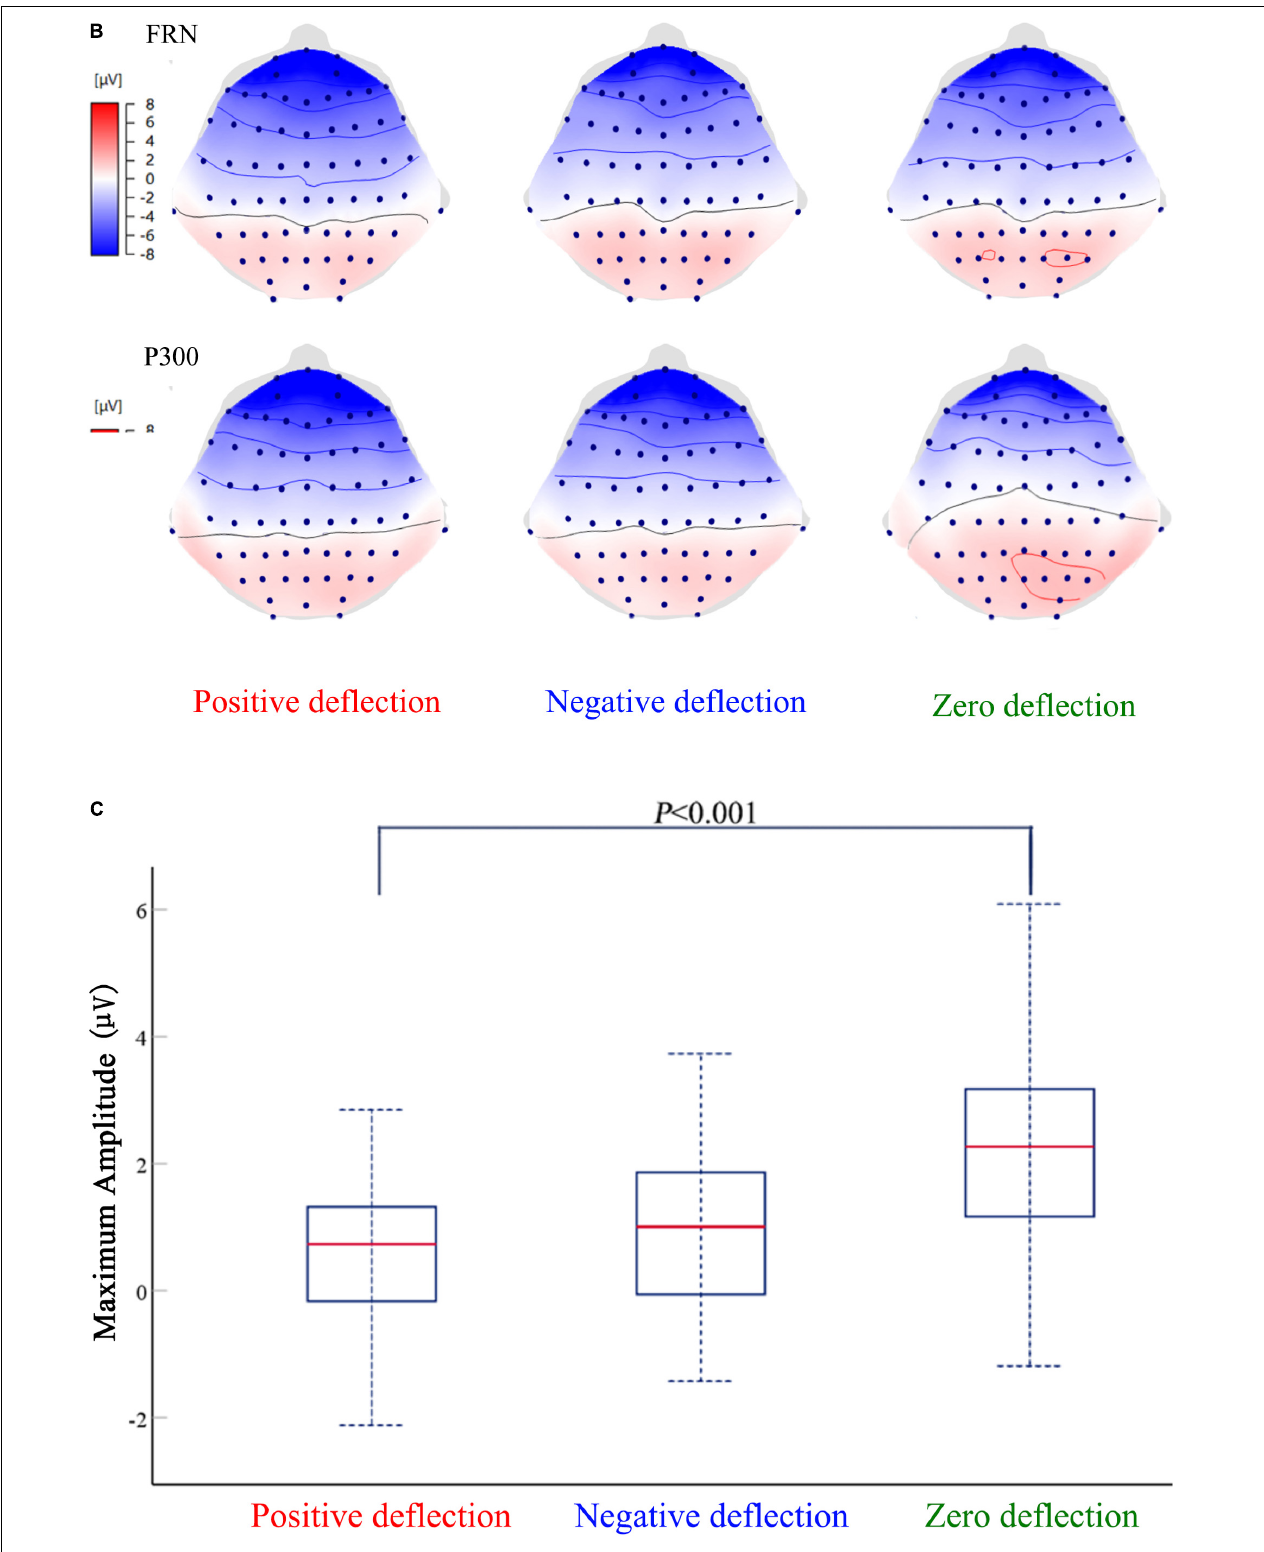
FIGURE 2 | (A) The grand averaged event-related potentials (ERPs) waveforms at FZ, FCZ, CZ, CPZ, and PZ of social norm deviation in Task 1. (B) The scalp distribution of feedback-related negativity (FRN) and P300 of social norm deviation in Task 1. (C) ANOVA results of social norm deviation in Task 1.